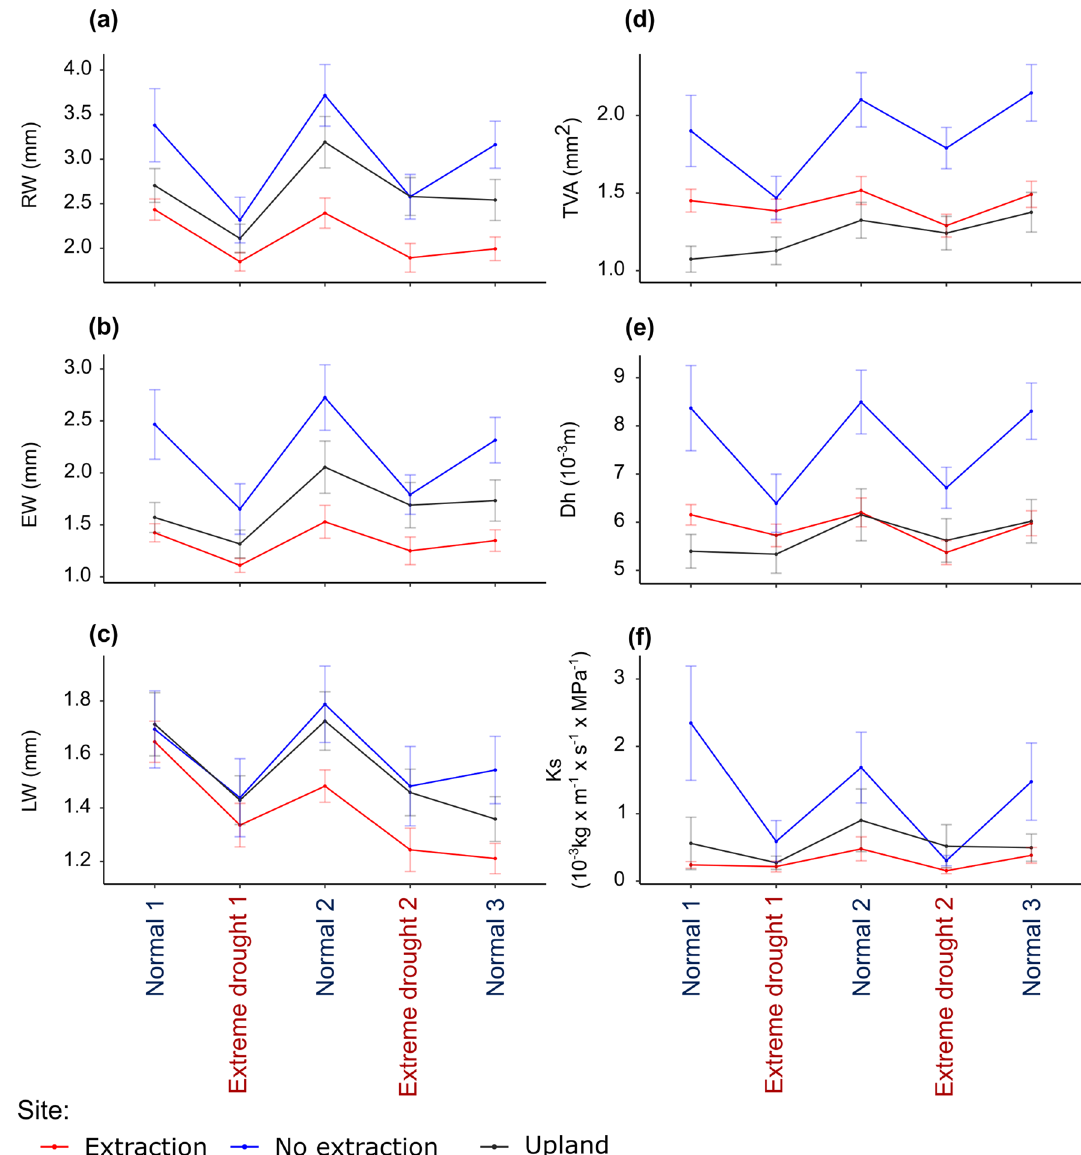
Figure 3. Development of growth: ( a ) ring-width (RW); ( b ) earlywood-width (EW); ( c ) latewood-width (LW), vessel and hydraulic variables: ( d ) total vessel area (TVA); ( e ) hydraulic diameter (Dh); ( f ) theoretical hydraulic conductivity (Ks) in the periods during the two droughts as well as pre, and post-drought (normal). See also Supplementary Fig. S4 for the exact non-dry years considered in the pre- and post-drought periods. Points indicate average values of each ring-width or vessel related variable and bars show the standard error of the more pronounced for the indices of recovery and resilience and weaker for resistance. Trees at no extraction sites showed the lowest resistance to drought regarding almost all variables. However, differences among sites and tree vigour groups in resistance were only significant for RW and Ks. Healthy trees at no extraction sites had significantly lower RW resistance than both vigour groups at upland sites (Fig. 6a). Remarkably, resistance regarding Ks was higher (i.e. less pronounced reductions in Ks during drought compared to the pre-drought levels) in declining trees from extraction sites and trees from upland sites regardless of vigour than in trees at no extraction sites (Fig. 7g). Post-drought recovery of ring width variables was highest in healthy trees from no extraction sites (Fig. 6). Recovery of vessel related variables was highest in both healthy and declining trees at no extraction sites (Fig. 7). The differences among sites regarding resilience were less pronounced than the differences in recovery for all 6 ring-width and vessel related variables. However, differences in resilience were more noticeable between tree vigour groups, with healthy trees demonstrating higher resilience than declining trees at all sites and for almost all variables. Declining trees at the extraction sites showed the lowest resilience in RW (Fig. 6c) and TVA (Fig. 7c).